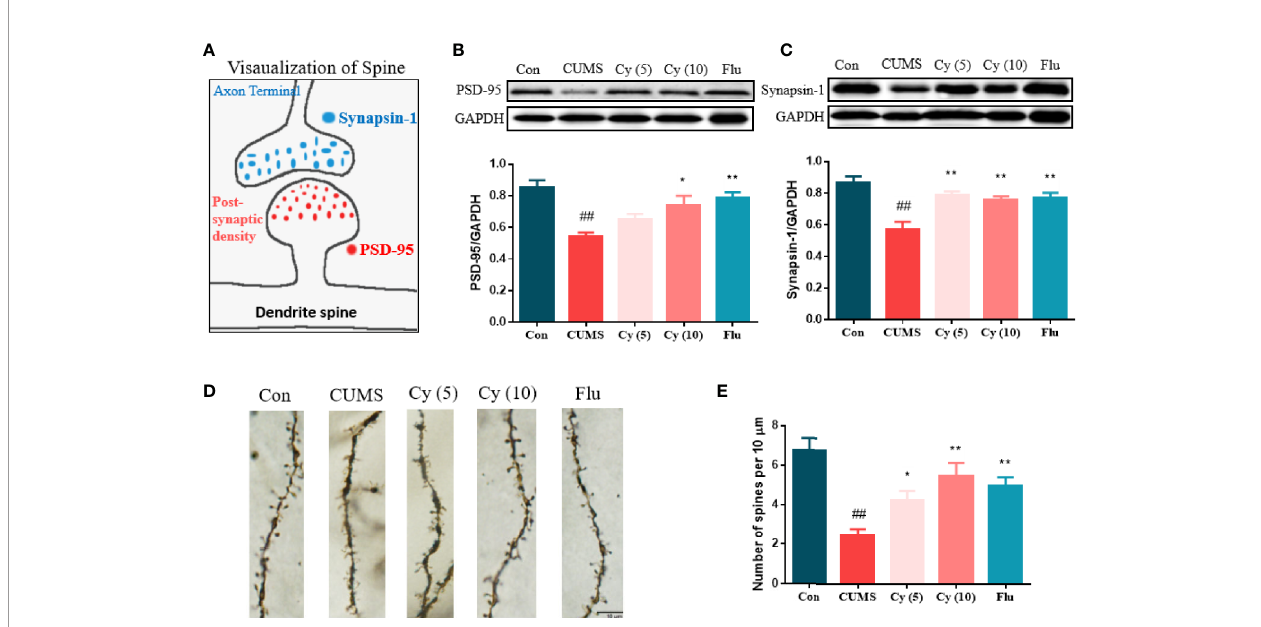
FIGURE 4 | Synaptic proteins and dendritic spine density in the hippocampus. PSD-95 and Synapsin-1 are postsynaptic and presynaptic protein respectively (A) . Cy intervention signi fi cantly restored CUMS-induced decrease in PSD-95 (B) and Synapsin-1 (C) , as well as the de fi ciency in dendritic spine density (D, E) . Data are represented as mean ± SEM. ## p < 0.01 vs. Con group. * p < 0.05 and ** p < 0.01 vs. CUMS group.